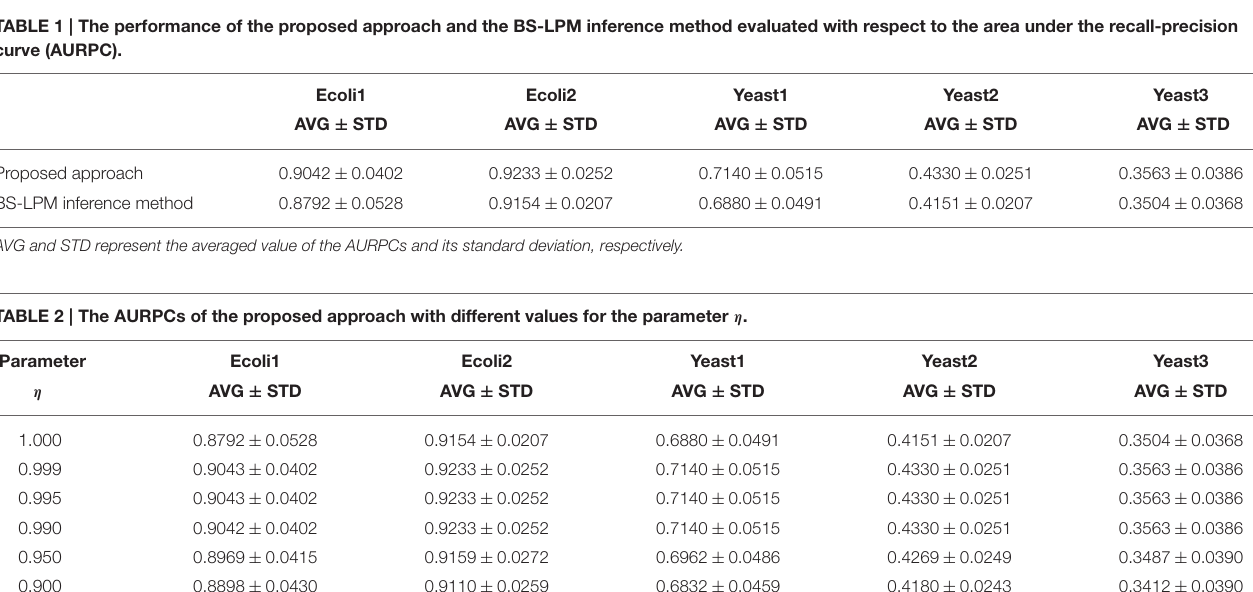
TABLE 1 | The performance of the proposed approach and the BS-LPM inference method evaluated with respect to the area under the recall-precision curve (AURPC). Ecoli1